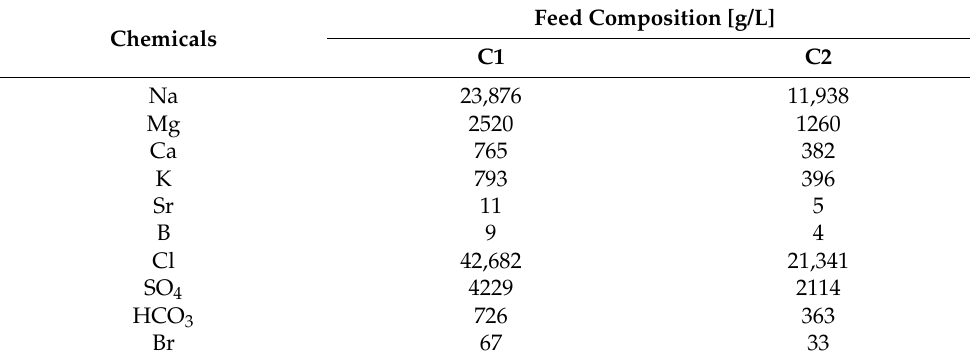
Table 1. Detailed chemical constituents in prepared thermal brine